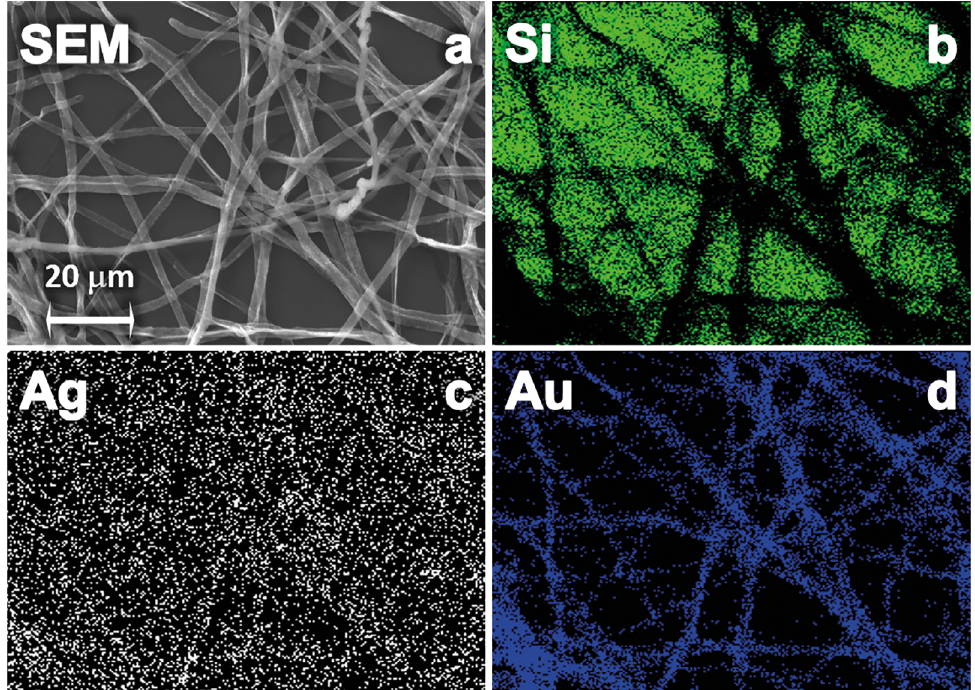
Figure 4. SEM images and EDX mapping in 2D of the elements (b) Si, (c) Ag and (d) Au that compose the filamentous fungus Aspergillus aculeatus in the border of mycelial mass covered exclusively with gold